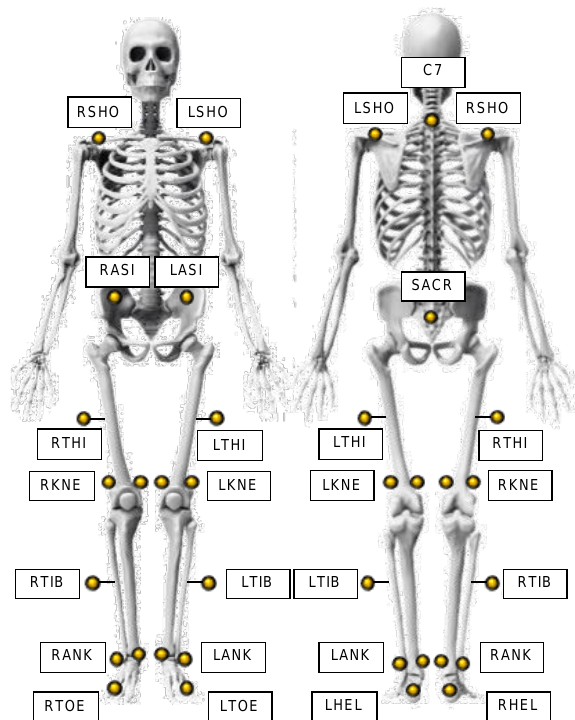
Figure 2. The Conventional Gait Model marker set. LSHO/RSHO : Left/Right Shoulder. Markers on Left/Right acromioclavicular joint. LASI/RASI : Left/Right ASIS. Markers over Left/Right anterior superior iliac spine. LTHI/RTHI: Left/Right thigh. Wand marker over the lateral aspect of the thigh. LKNE/RKNE: Left/Right Knee. Markers on lateral epicondyle of the Left/Right knee. LTIB/RTIB: Left/Right Tibia. Wand marker over the lateral aspect of the tibia. LANK/RANK: Left/Right Ankle. Markers on lateral malleolus along an imaginary line that passes through the trans-malleolar axis. LTOE/RTOE: Left/Right Toe. Markers are placed on the lateral aspects of the foot at the fifth metatarsal head. LHEL/RHEL: Left/Right Heel. Markers positioned so that the hell-toe marker vector is parallel to the sole of the foot and aligned with the foot progression line. SACR: Sacrum. The marker is positioned over the subject’s sacrum. C7: 7th Cervical Vertebrae. Markers over the spinous process of the 7th cervical vertebrae.